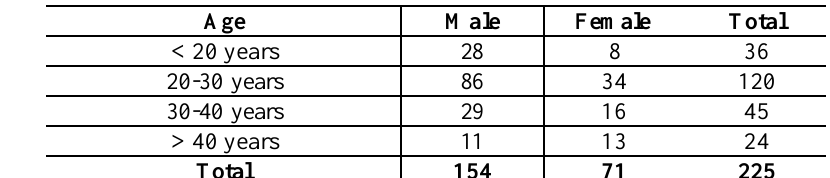
Table I : Age and Sex Distribution